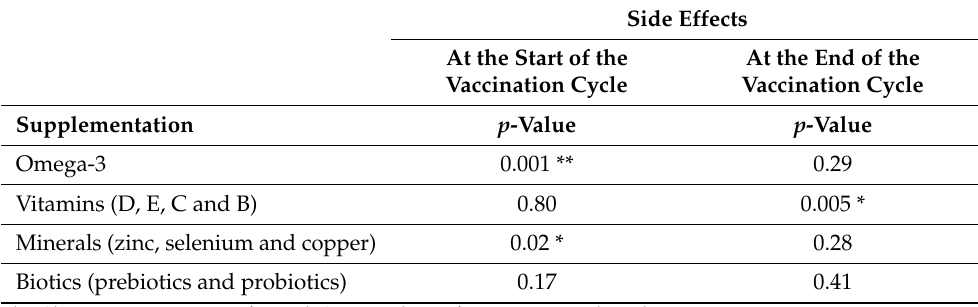
Table 7. Association between vaccination side effects and individual supplement intakes at the start and end of the vaccination cycle.